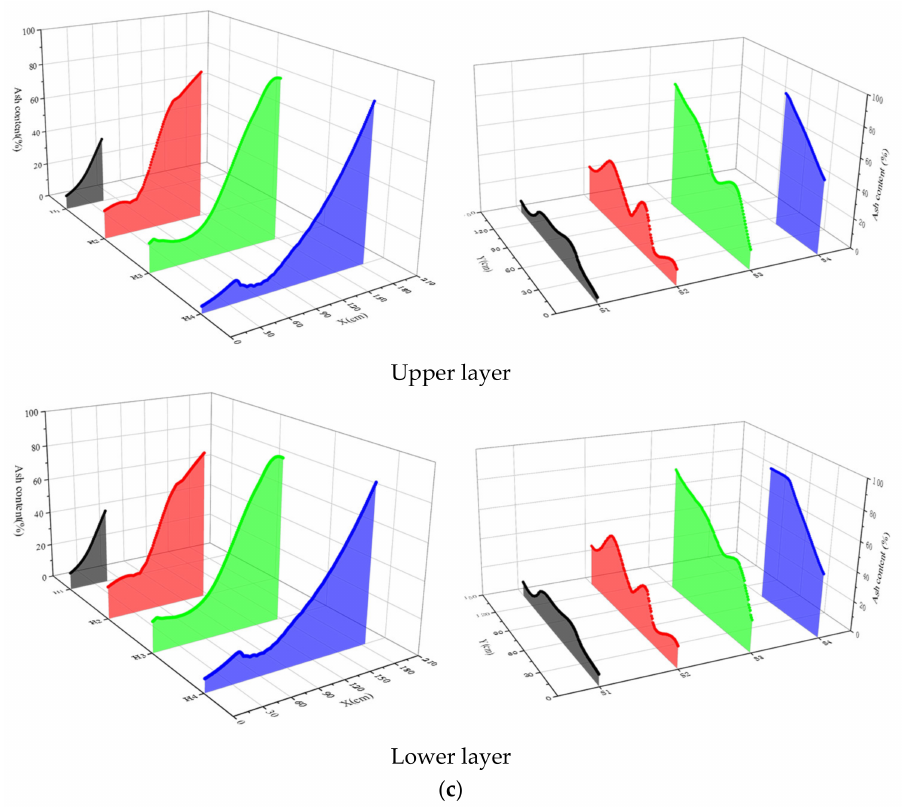
Figure 10. Ash distribution of upper layer and lower layer at 34 Hz vibration frequency. ( a ) Ash content distribution at 4.96 m/s of airflow. ( b ) Ash content distribution at 5.47 m/s of airflow. ( c ) Ash content distribution at 5.68 m/s of airflow.